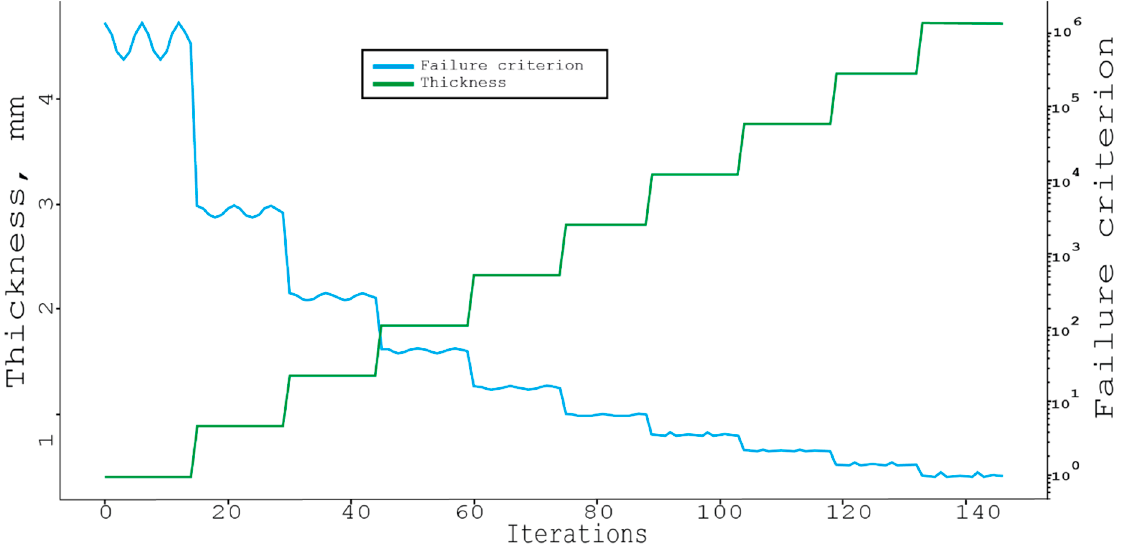
Figure 11. Tabu search through materials and angles with the step of 15 deg and a thickness = 4.8 mm 70.64 s, failure criterion = 0.92.